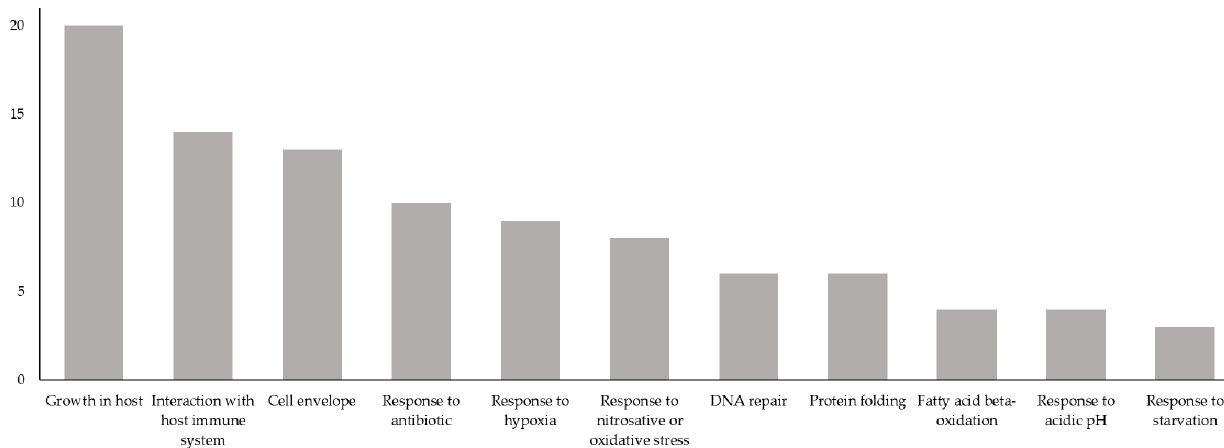
Figure 3. Biological process categories of the 72 proteins having biological processes related to the virulence or latency of MTB. X -axis: biological process categories relevant to MTB virulence or latency; Y -axis: number of novel Vaxign-ML-predicted PAgs having a GO biological process belonging to a given biological process category. Total exceeds 72 because several novel Vaxign-ML-predicted PAgs have GO biological processes belonging to more than one biological process category.